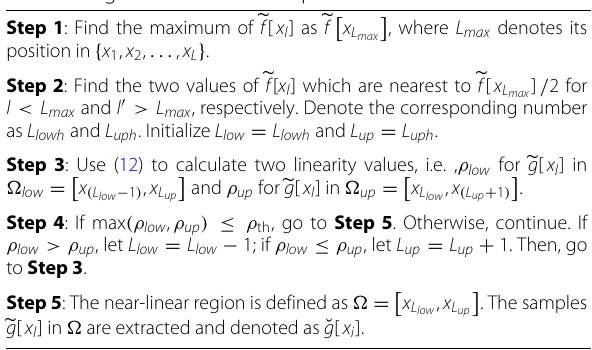
Table 1 Algorithm of ZMNL sample